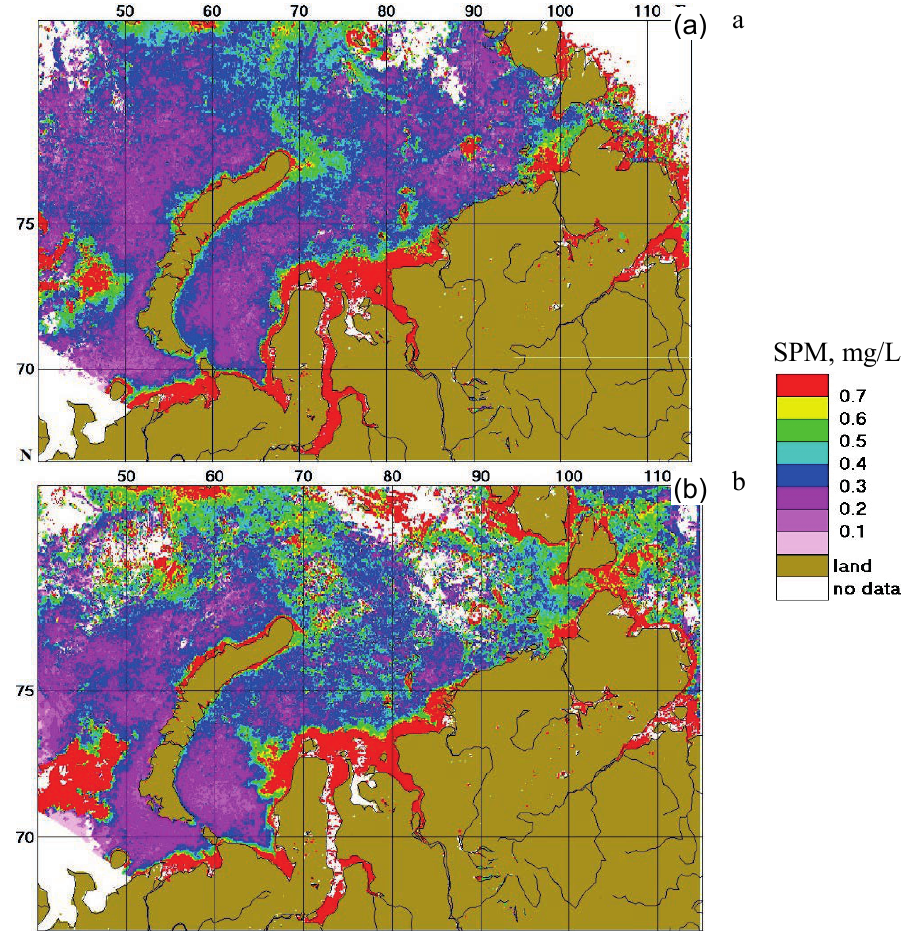
Fig. 2 Satellite images of sea surface monthly average SPM distribution for the Kara Sea (derived from MODIS-Aqua data). Images are composites over September 01–30, 2007 (a) and 01–30, 2011 (b), provided by IO RAS Ocean Optic Laboratory, http://optics.ocean.ru (Kuznetsova et al